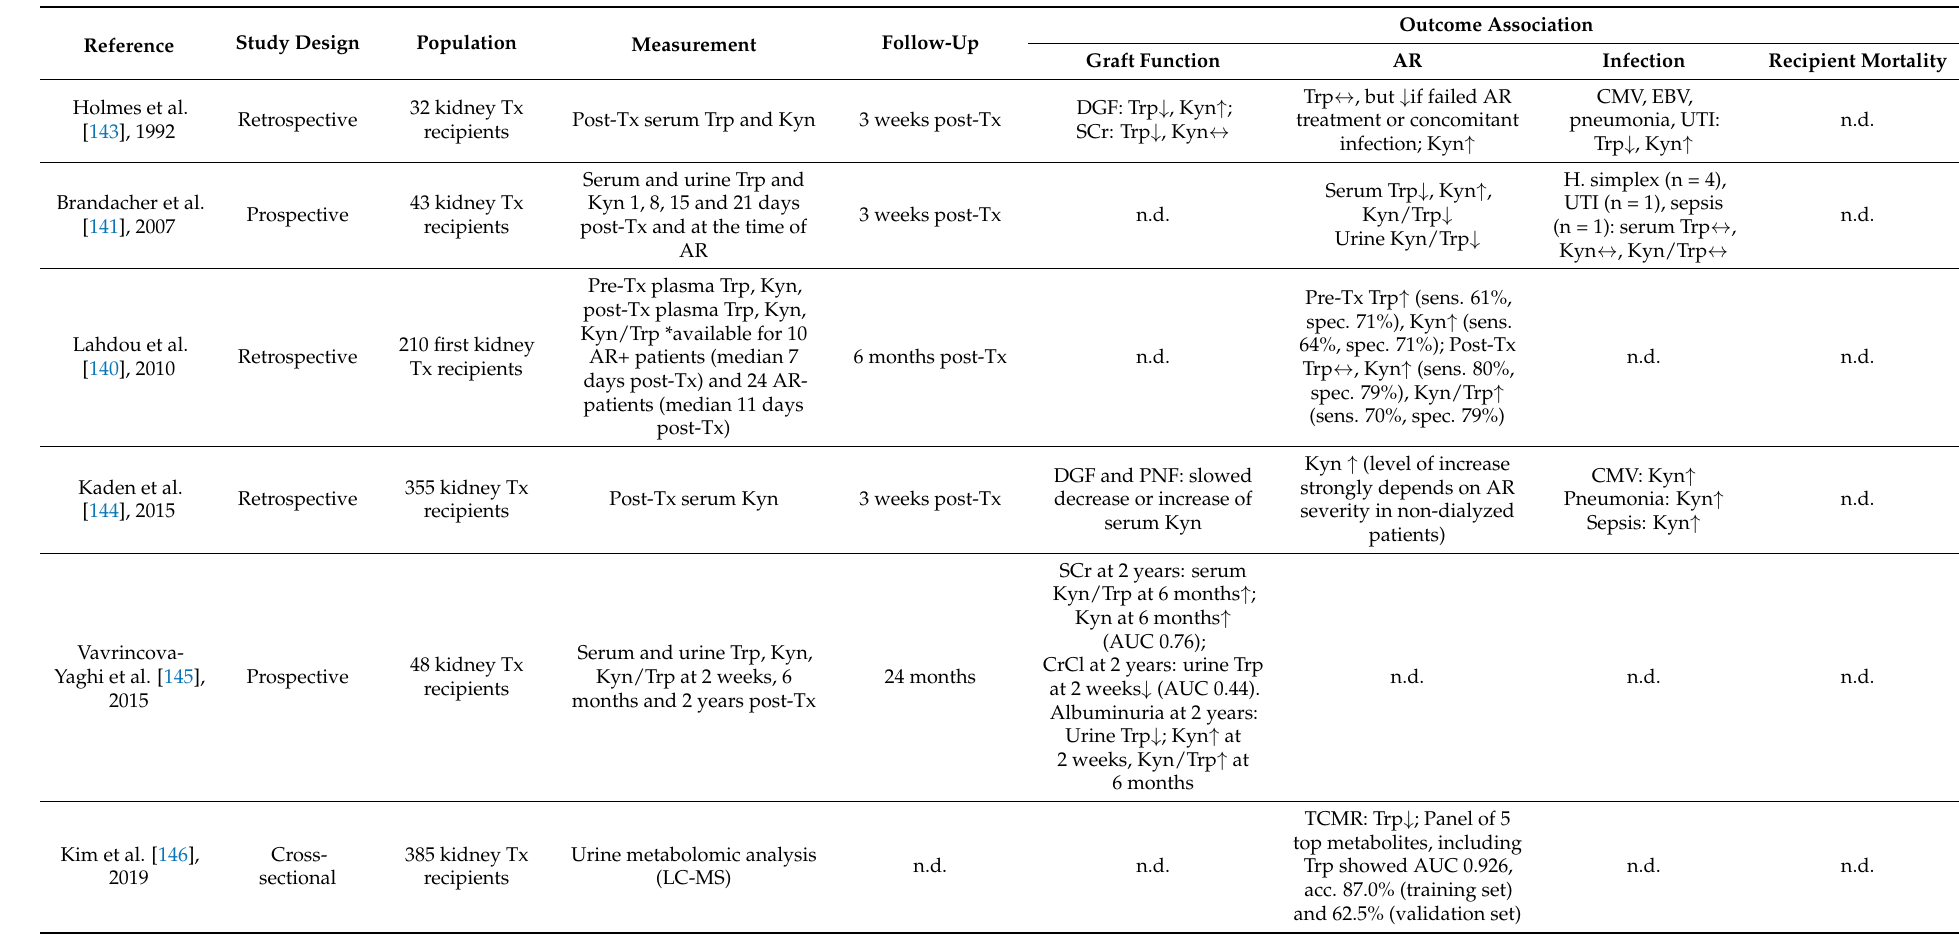
Table 3. Tryptophan and its metabolite association with post-Tx outcomes in human